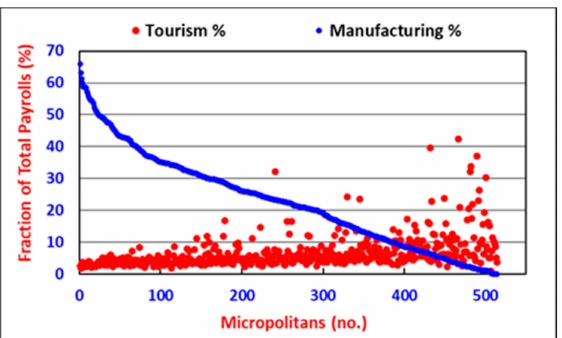
Figure 14. Payroll strengths (% of total) of the micropolitans, compared with ranked manufacturing sector strengths (% of total).